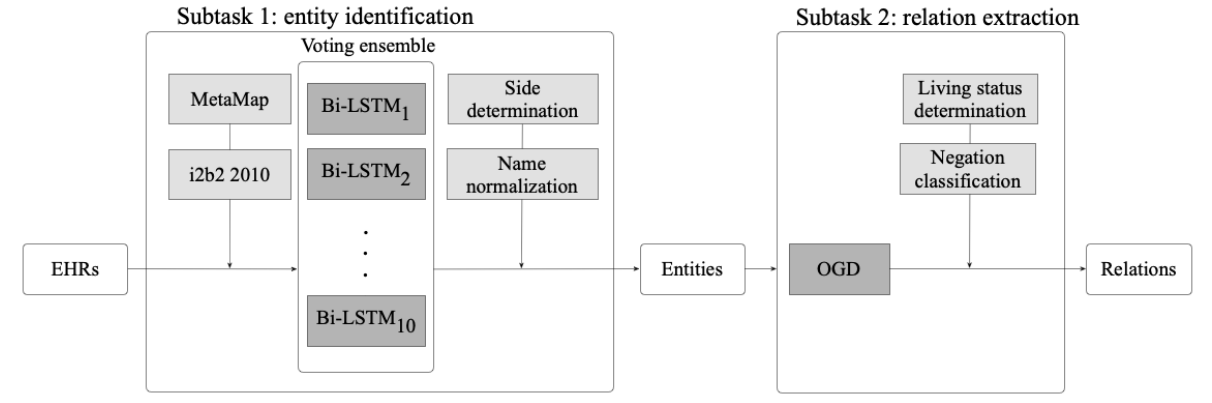
Figure 1. End-to-end system architecture. Bi-LSTM: bidirectional long short-term memory; EHR: electronic health record; i2b2: Informatics for Integrating Biology and the Bedside; OGD: online gradient